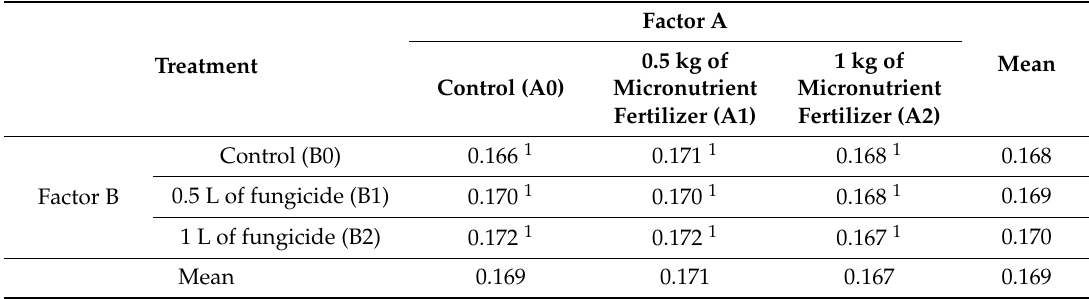
Table 7. E ff ect of the micronutrient fertilizer and fungicide on Kotowski’s index, denoting the mean number of germinated seeds per